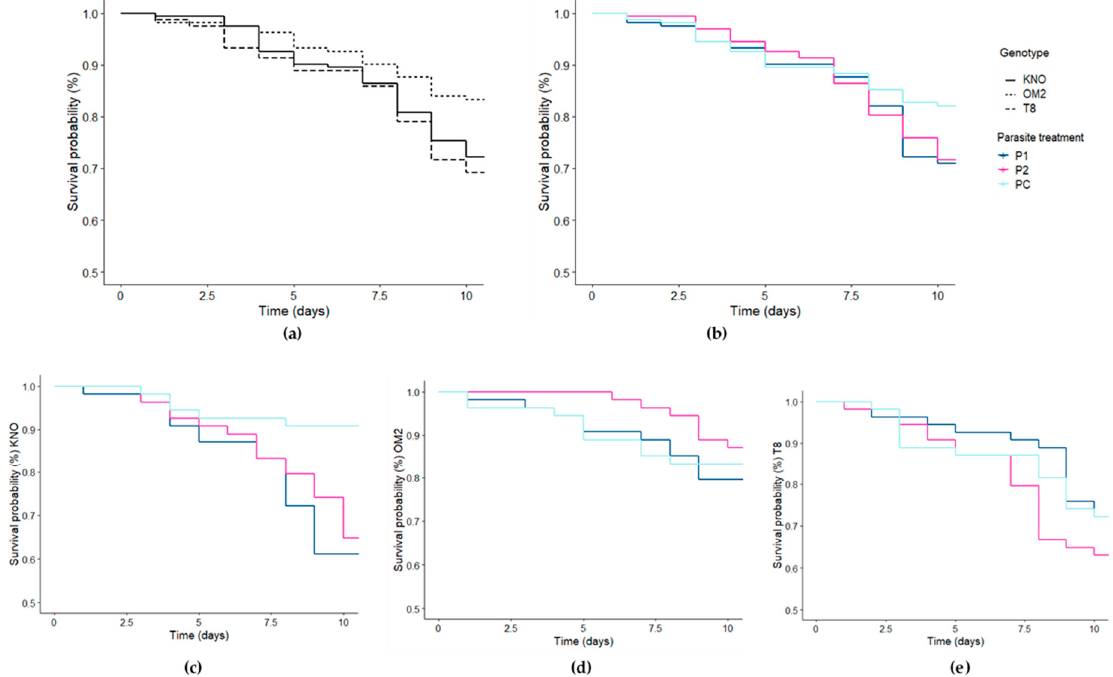
Figure 4. Survival curves for the Daphnia individuals for the different ( a ) genotypes, ( b ) parasite community treatment, ( c ) parasite community treatment for the KNO genotype, ( d ) parasite community treatment for the OM2 genotype, and ( e ) parasite community treatment for the T8 genotype. Line type indicates the genotype (solid = KNO, dotted = OM2, dashed = T8). Line color indicates the parasite treatment (dark blue = P1, pink = P2, light blue = PC).